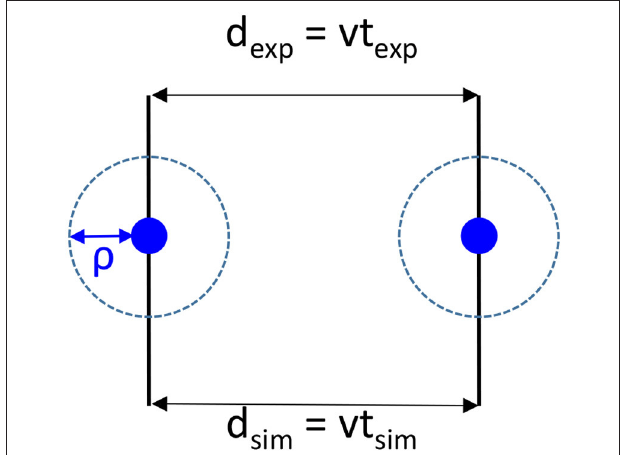
FIGURE 2 | Schematics of the collision between two species (blue discs) both in simulations and in experiments and definitions of the interaction distance ρ , the distances d exp , d sim and times t exp , t sim between two collisions, respectively for experiments and simulations. v is the velocity which should be the same in experiments and